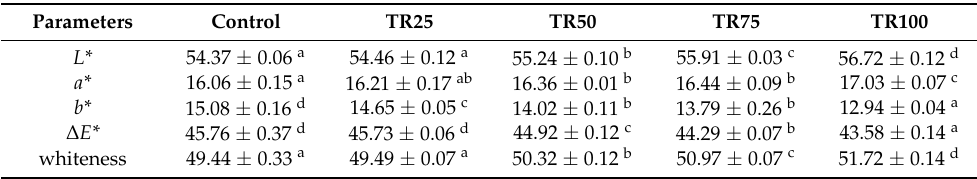
Table 3. Color parameters of sausages with pork fat replaced by